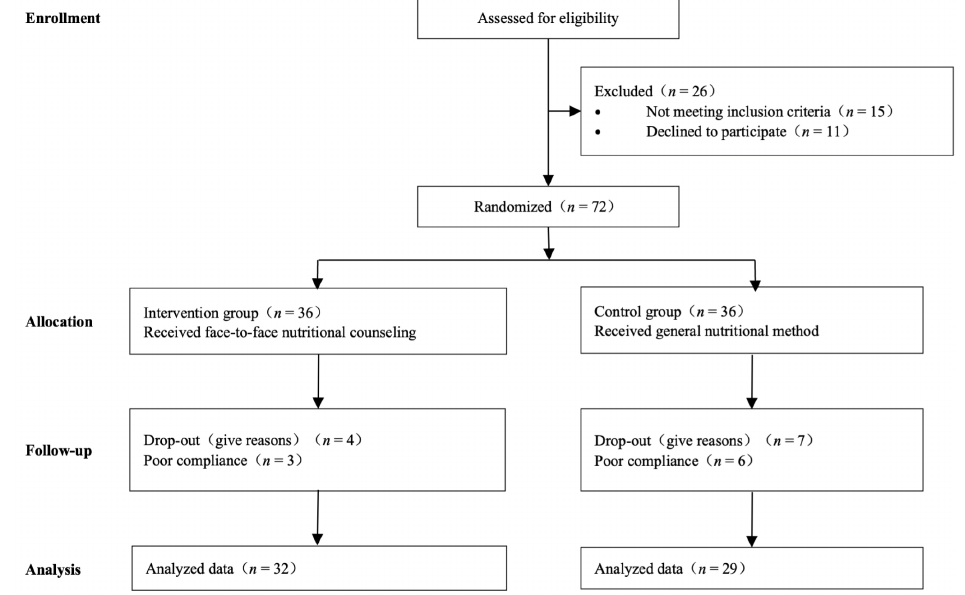
Figure 1. Flow of participants, participant screening, randomization, and follow-up. Table 1. Basic characteristics of the patients (Mean ± SD); Abbreviations: HADS-A, Hospital Anxiety and Depression Scale- Anxiety; HADS-D, Hospital Anxiety and Depression Scale- Depression; KPS, Karnofsky Performance Status; ONS, Oral Nutrient Supplements.